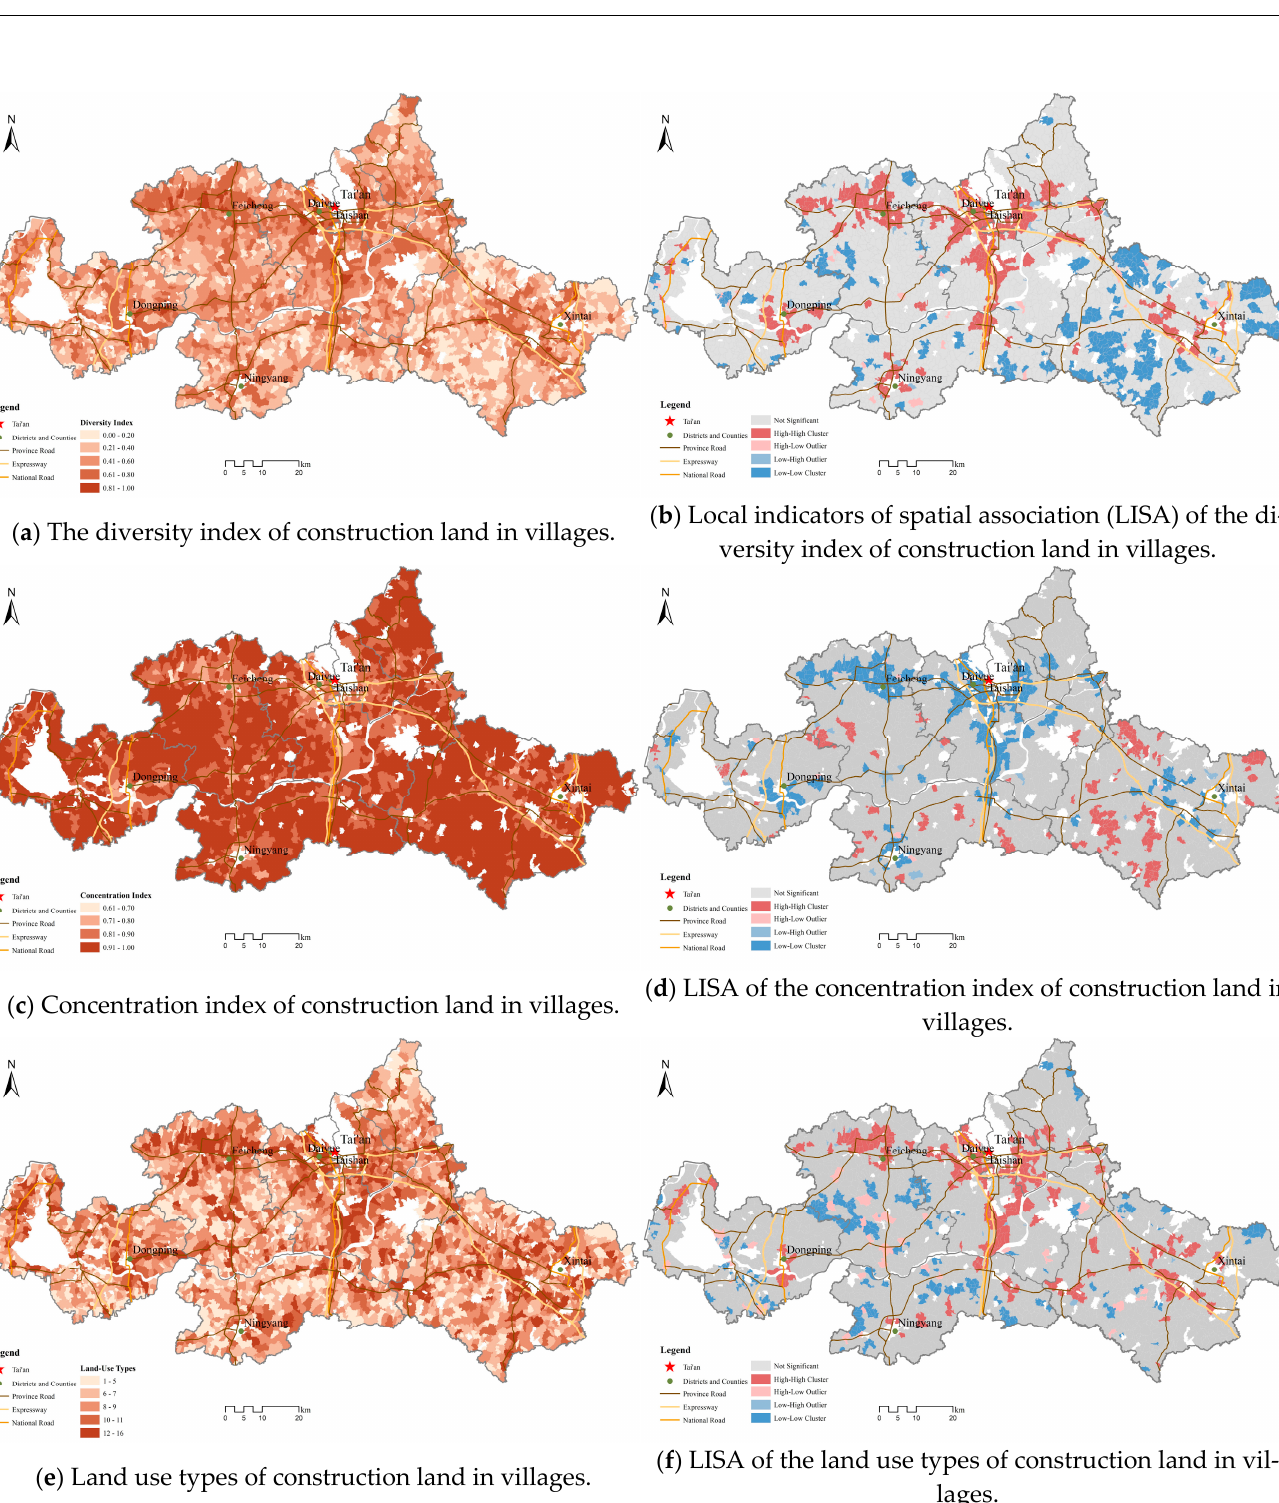
Figure 2. Structural indices of rural construction land structure in Tai’an.